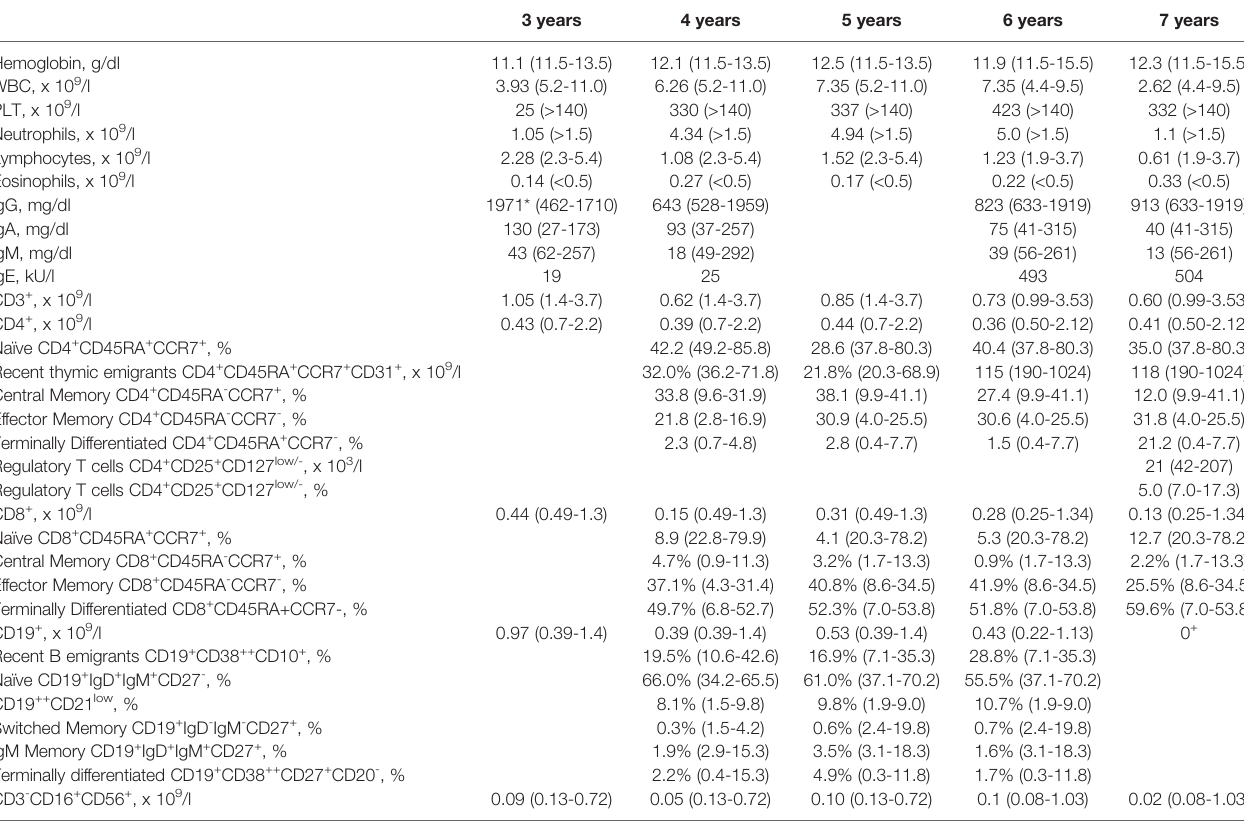
* After IVIg. + After rituximab therapy. Age-matched normal values are given between round